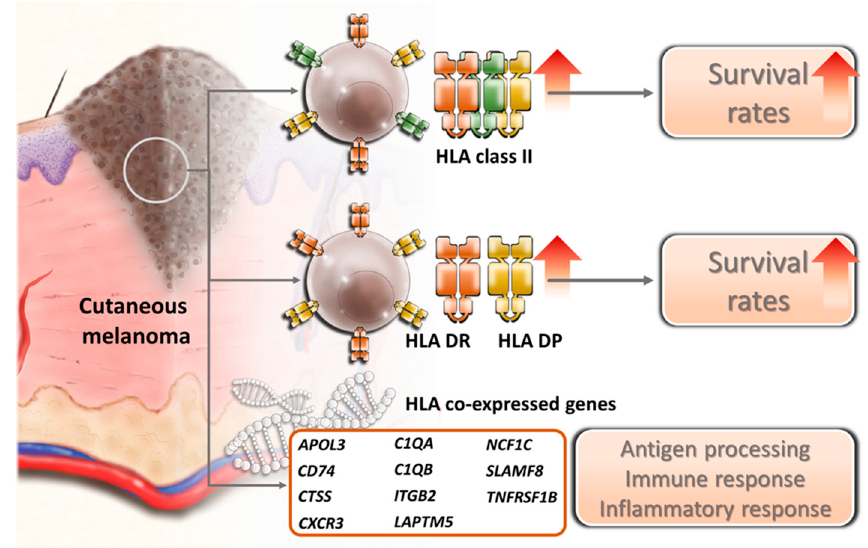
Figure 9. Schematic summary of the effect of HLA class II genes and their co-expressed genes in prediction of overall survival in cutaneous melanoma. The arrows indicated increased expressions and increased survival rates.